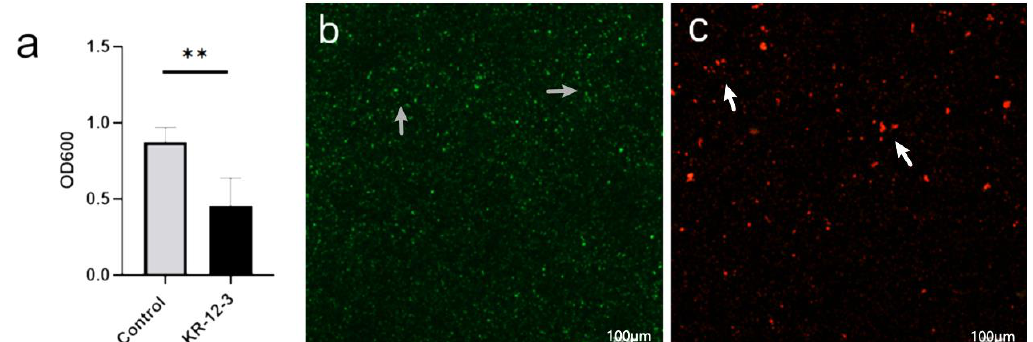
Figure 2. Antimicrobial effects of KR-12-3 against S. gordonii. S. gordonii biofilms were treated with KR-12-3 for 24 h ( a ). The data are presented as mean ± SD; n = 3. ** p < 0.01 compared with control groups. The biofilms were stained and imaged by CLSM. Images of the control group show ma- ture S. gordonii biofilms as indicated by grey arrows ( b ). The CLSM image of the KR-12-3 treat- ment group showed no obvious viable bacteria, only some dead bacteria, as indicated by the white arrows ( c ). The green color represented live bacterial cells, and the red/orange color represented dead bacterial cells. PBS was tested as a buffer control. The experiments were all repeated at least 3 times.